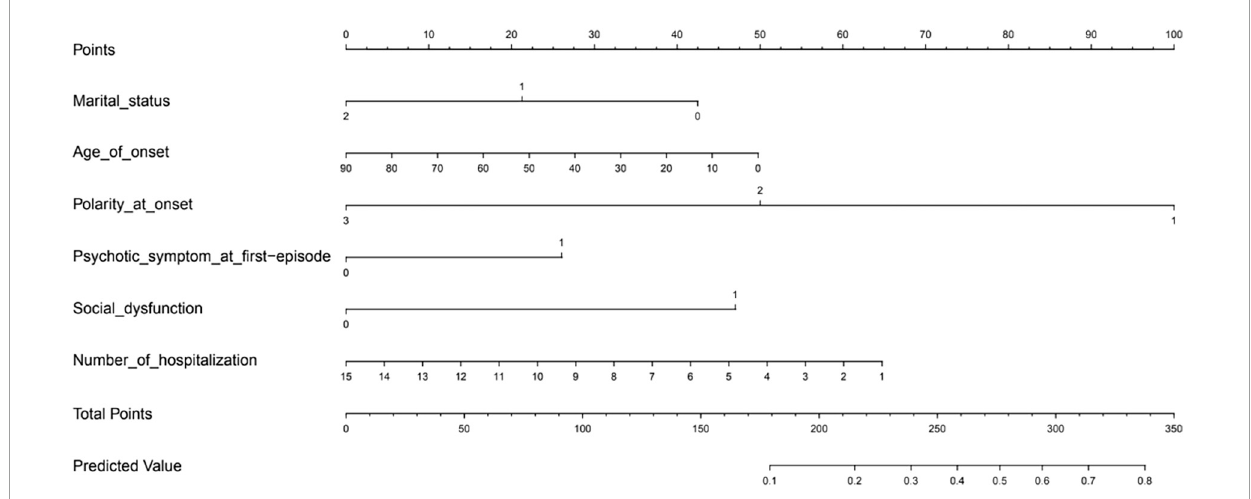
FIGURE2 The prediction nomogram of risk factors for non-suicidal self-injury (NSSI) in patients with mood